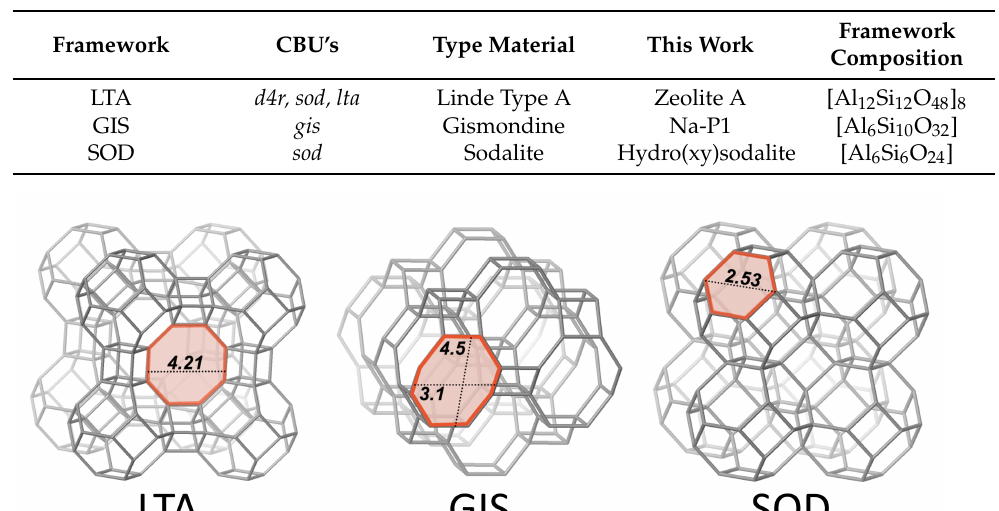
Table 1. Overview of selected zeolitic framework structures and compositions relevant for this study. Data for composite building units (CBU’s), type materials and framework compositions was obtained from [40].